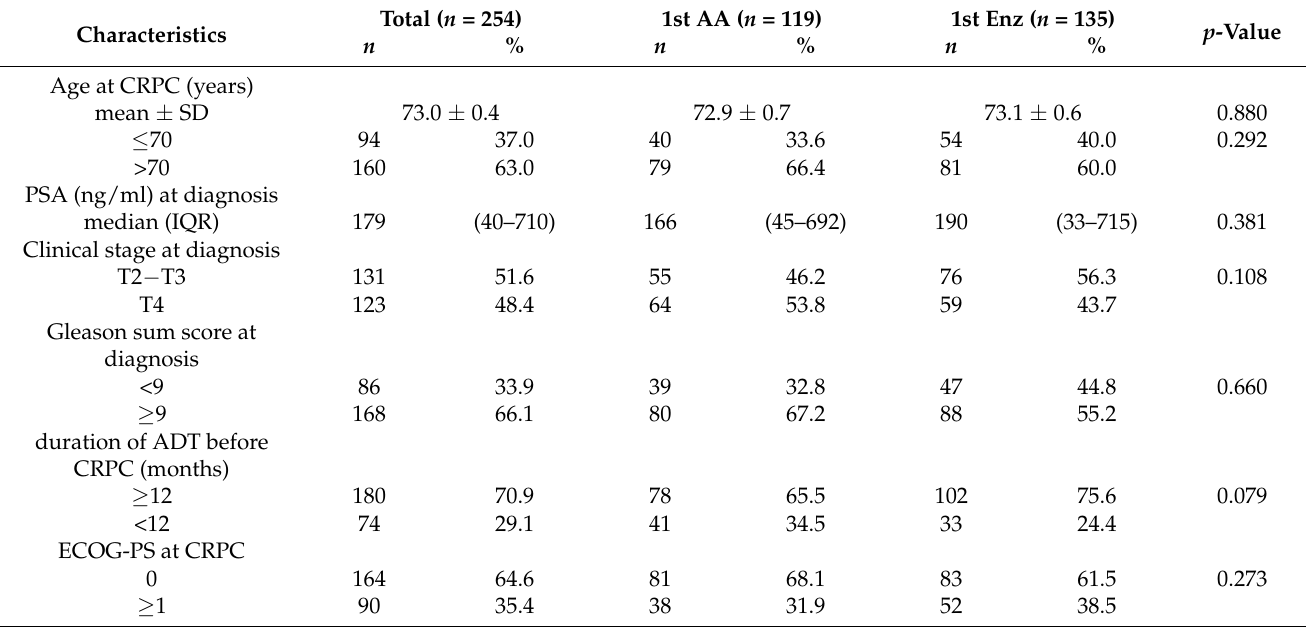
Table 1. Clinical Characteristics in 254 mCRPC patients treated with abiraterone: AA ( n = 119) or enzalutamide: Enz ( n = 135) at the first-line